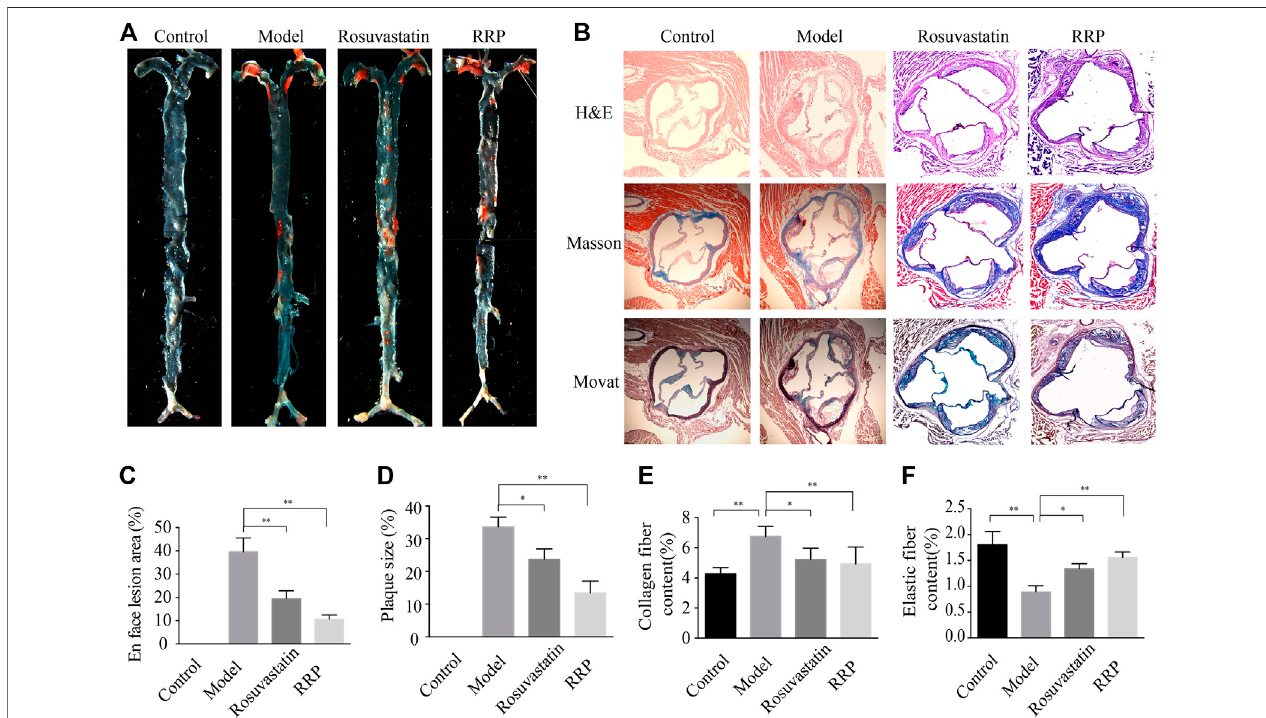
FIGURE 2 | RRP affects the development of atherosclerosis. (A) Representative Oil-red O staining of the entire aorta. (B) Representative images of H&E, Masson, and Movat staining of the aortic root (magni fi cation, × 50). (C) Quanti fi cation of the en face lesion area of the entire aorta. (D) Percentage of aortic plaque area. (E) Percentageofcollagen fi bercontent. (F) Percentageofelastinplaquearea(elastinperplaque).Thedataareexpressedasthemean ± SD, n (cid:2) 6foreachgroup. p p < 0.05 vs. the model group.